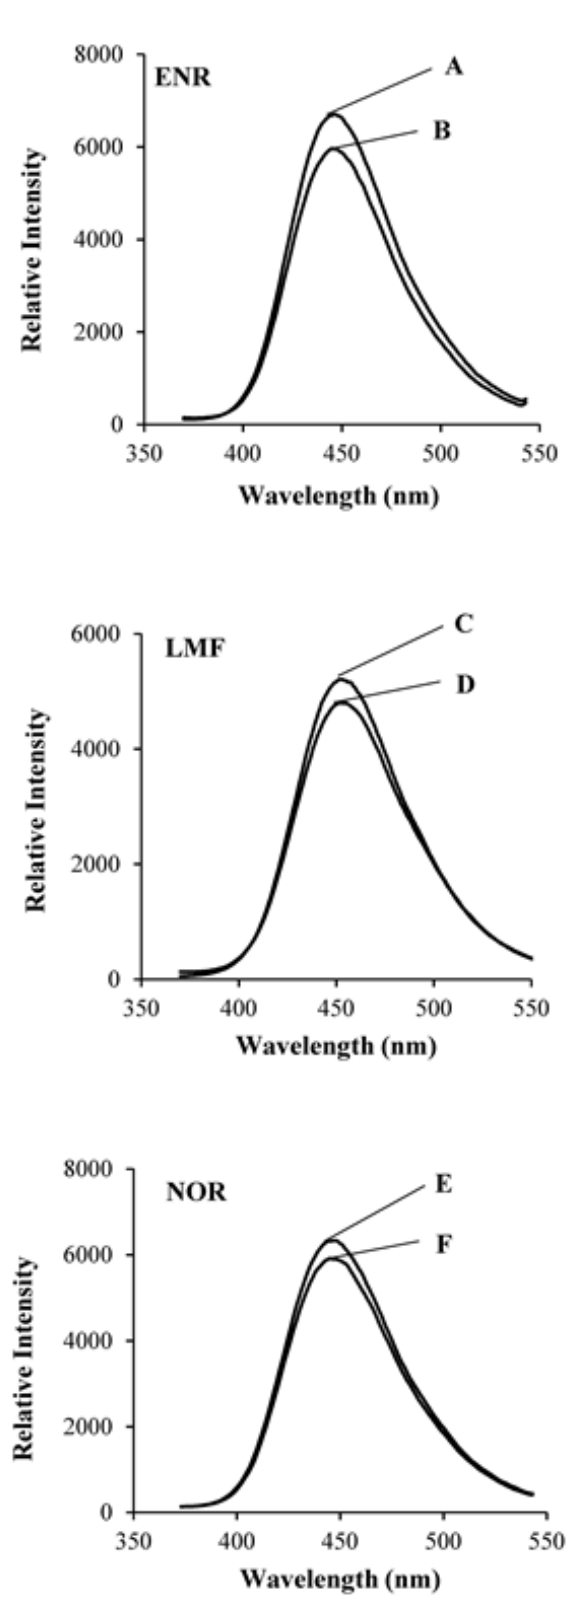
Figure 7: The emission spectra of the solutions with ENR injections (A and B), LMF ear (C) and eye drops (D) and NOR capsules (E and